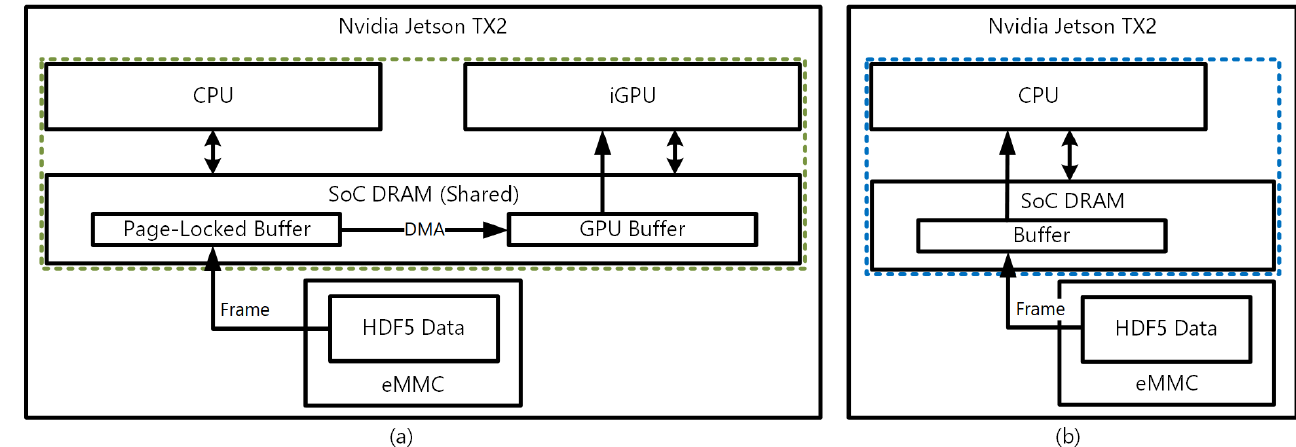
Figure 3. ( a ) Data flow diagram in the configuration involving the embedded Graphics Processing Unit (GPU). ( b ) Data flow diagram in the embedded Central Processing Unit (CPU) only configuration. Dotted lines mark the sections included in the evaluation measurements.